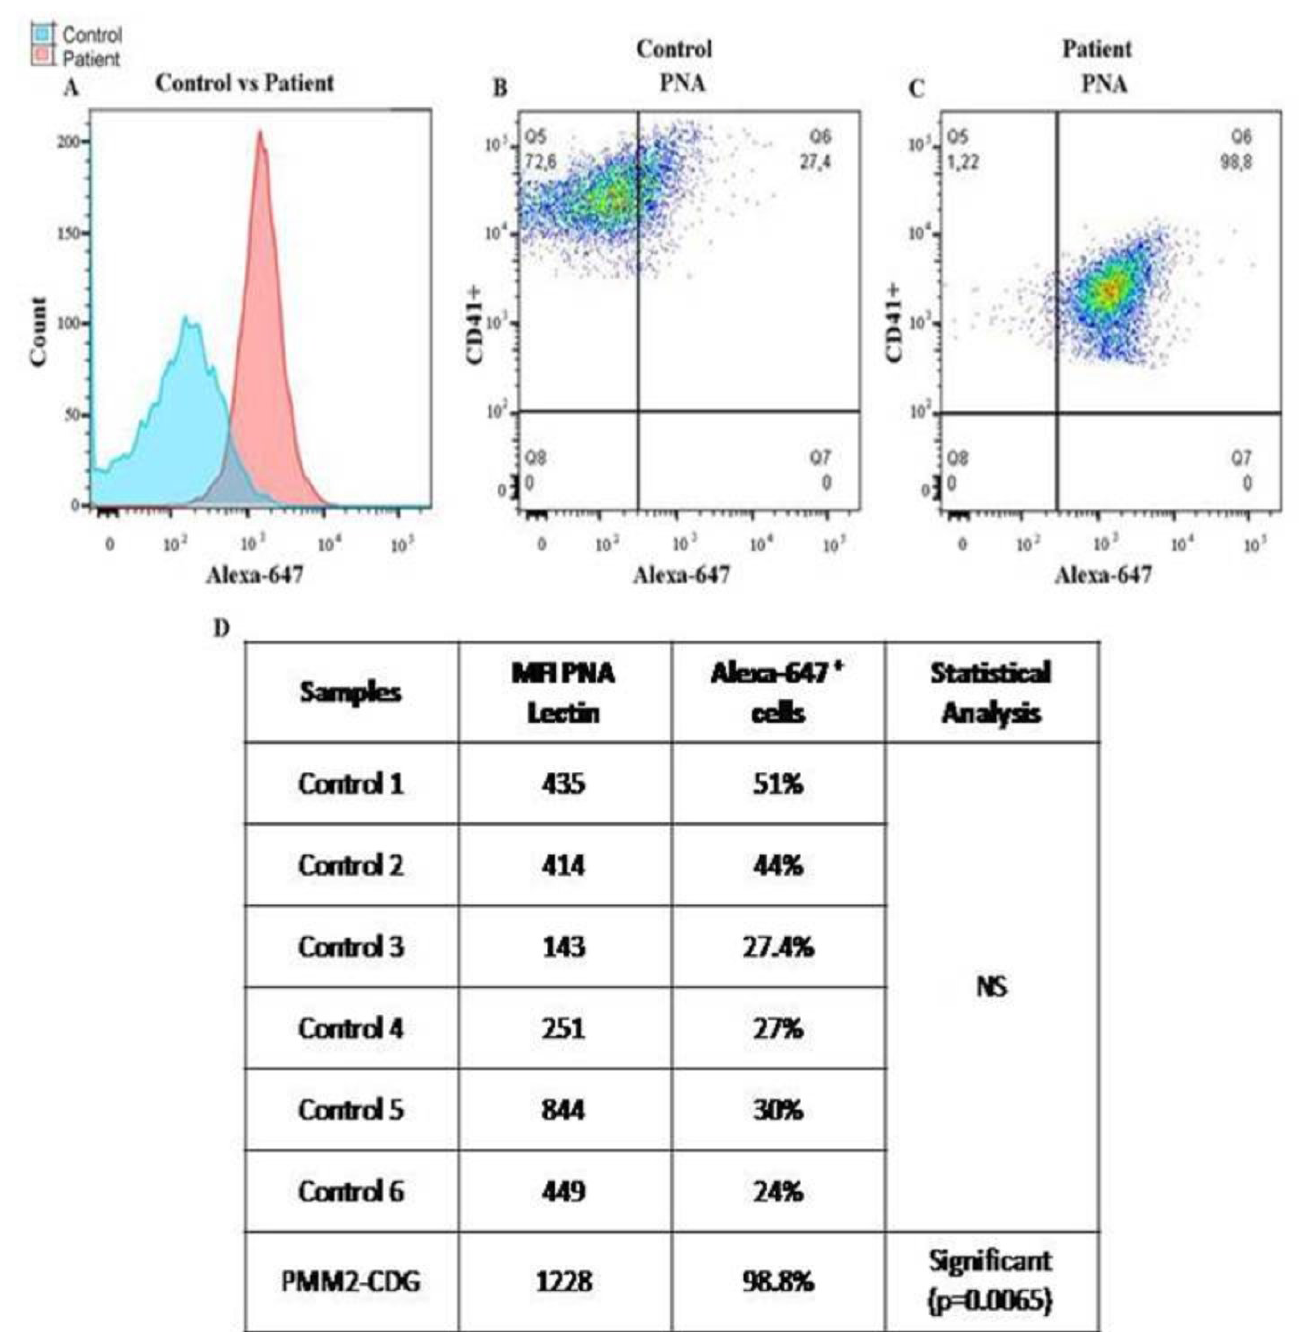
Figure 4. Enhanced binding of PNA to PMM2-CDG platelets. Platelet populations were gated based on positive CD41-PE staining and PNA lectin binding detected by Alexa Fluor 647-conjugated streptavidin. A . Representative MFI histogram showing PNA signal distribution in a control and a PMM2-CDG patient PRP sample. B-C. Representative dotplots of CD41 expression vs. PNA lectin signal in control and patient PRP samples. D. Summary results. MFI of the PNA signal and CD41 + / PNA + platelet counts(%) are indicated for control and PMM2-CDG patient